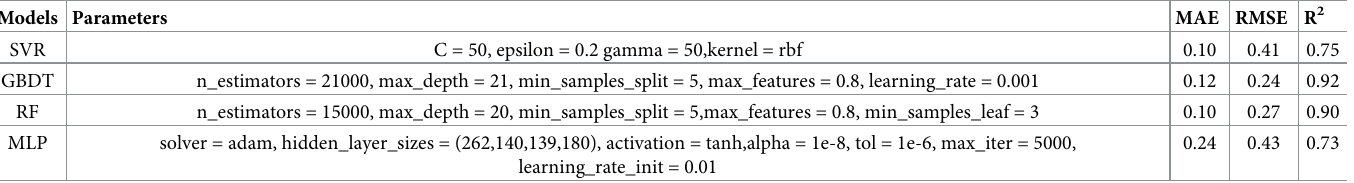
Table 2. Statistics of predicted bandgaps by SVR, GBDT, RF and MLP algorithms based on an 8-dimensional feature space. Models Parameters